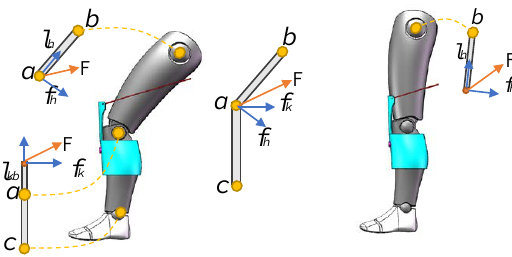
Figure 2. The two states of the Knee Board. Where a and b represent the knee and hip joint center respectively; l h and l kb represent the length of thigh and Knee Board, respectively; F is the tension in Bowden cable; and f h and f k represent the component forces in the hip and knee joints, respectively, which can produce the joint moment.